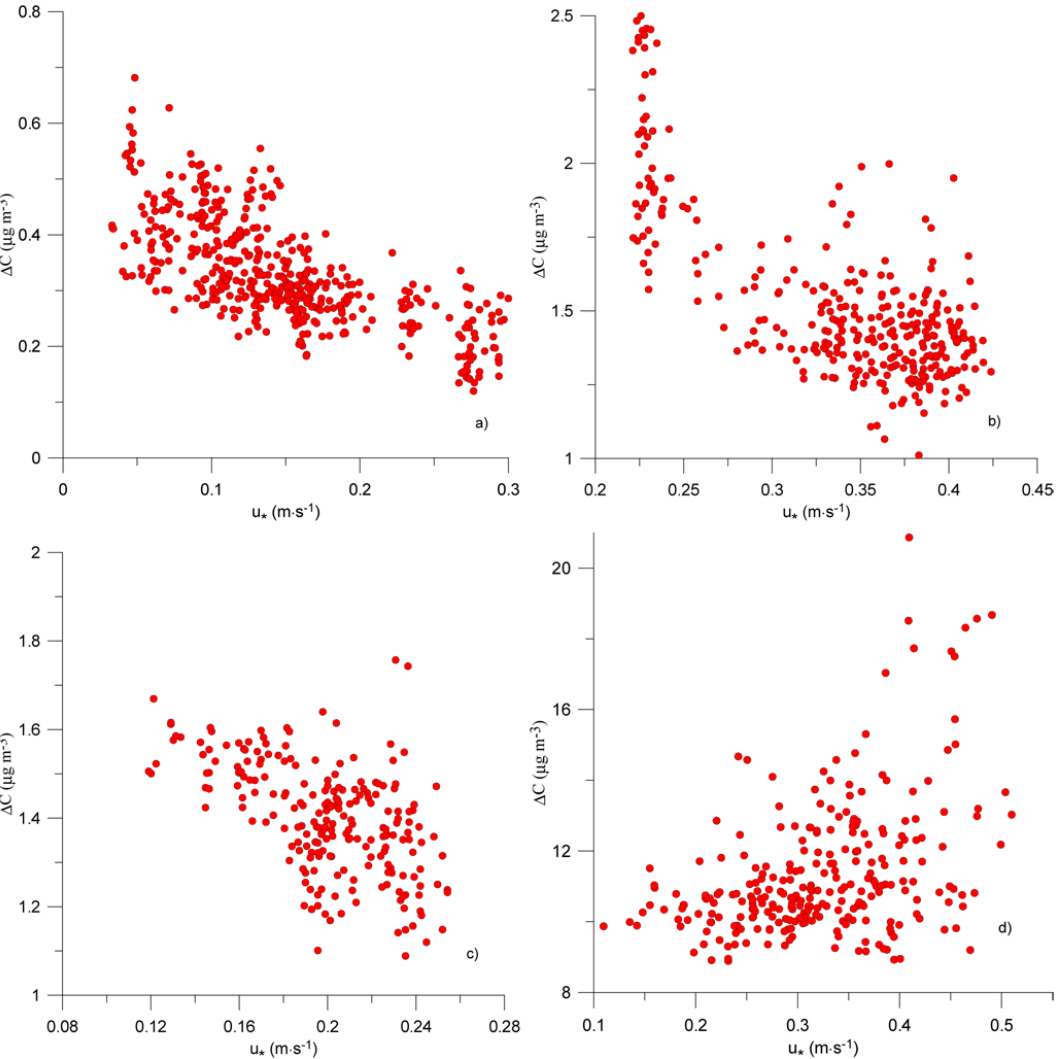
Fig. 9. Deviations of the aerosol mass concentration at a height of 0.5m from its background value for 2m (2007) or 1.5m (2009) (µgm − 3 ) for particles 0.15–0.5µm in size as a function of the friction velocity u ∗ : (a) 28 July 2007, (b) 30 July 2007, (c) 27 July a.m. 2009, (d) 20 July